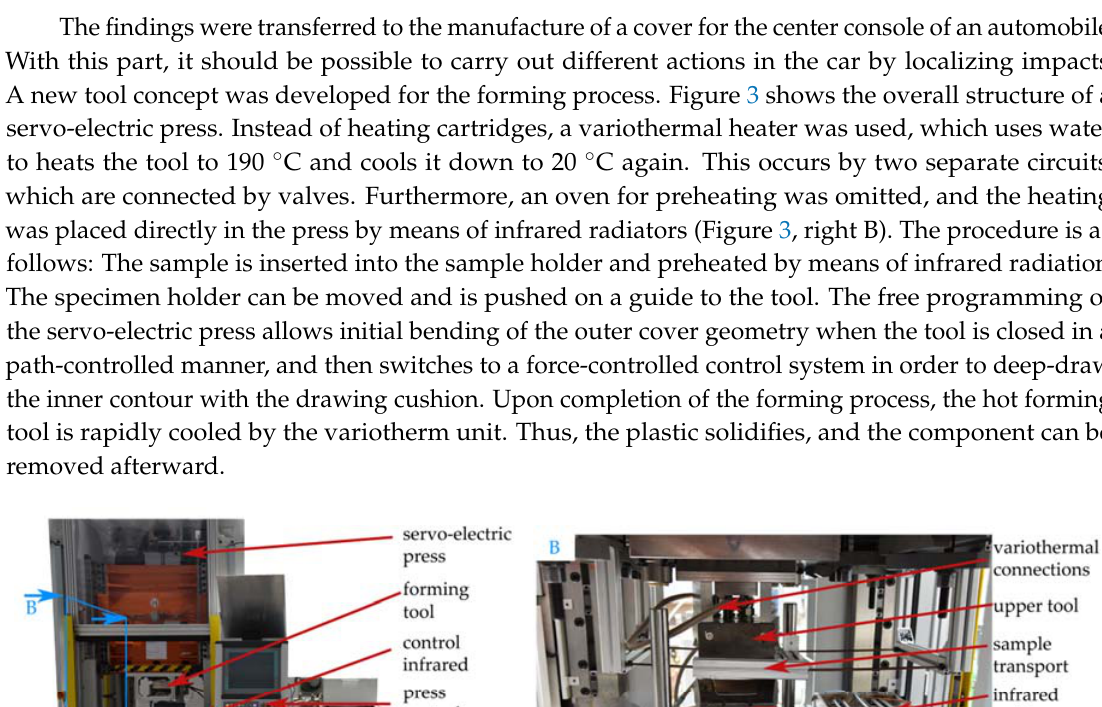
Figure 2. Continuous joining of aluminum sheets with piezoceramic foil and the top view (A).